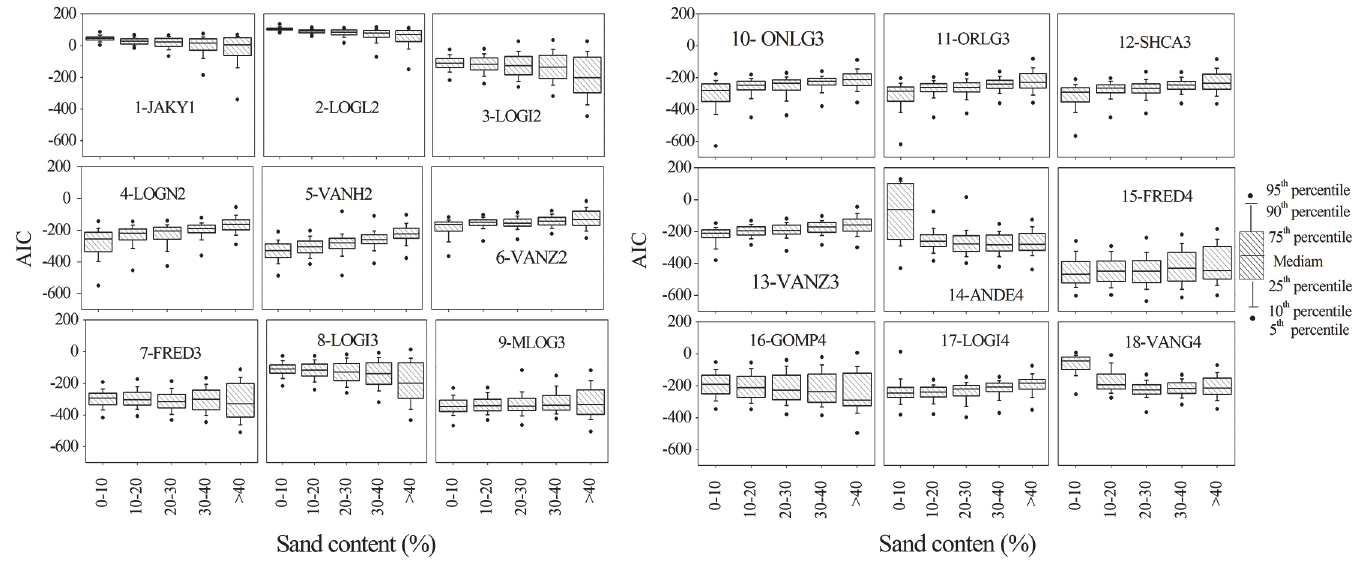
Fig 6. Box plots showing model performance with varying sand content of